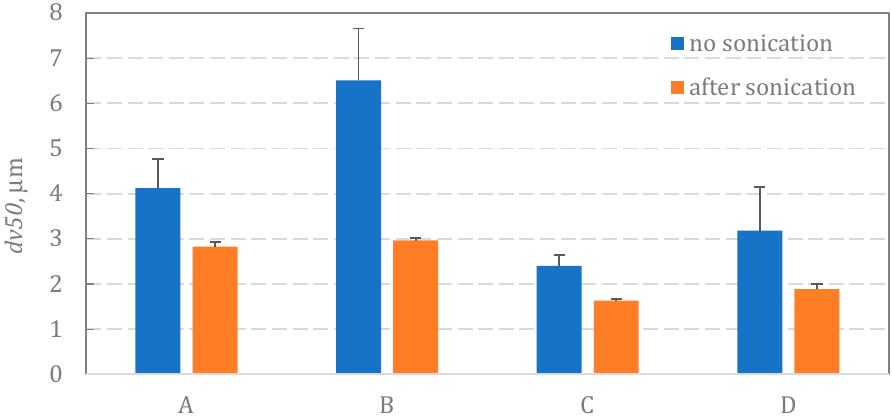
Figure 5. Median diameter of crystal size before and after sonication.